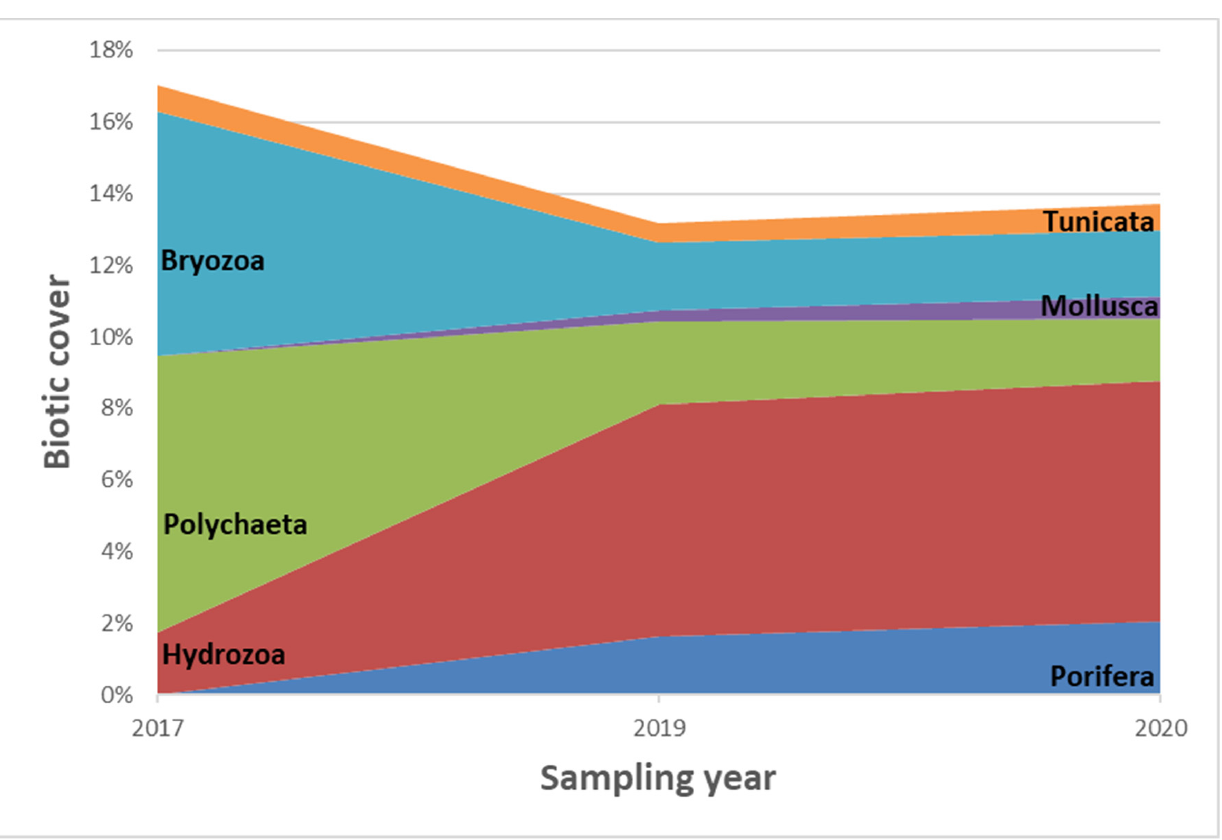
Figure 3. Biotic mean coverage of the major taxonomic groups of sessile invertebrates (%) showing changes over the years. Colors indicate different major taxonomic groups that contributed to the coverage of photoquadrats of the artificial reefs.